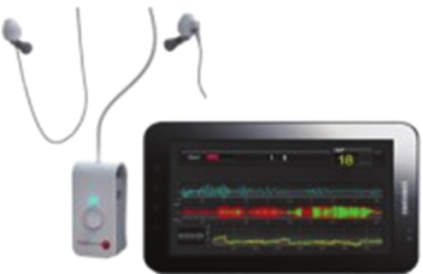
Figure 6: The “HeadSense” intracranial pressure monitor. Courtesy of HeadSense